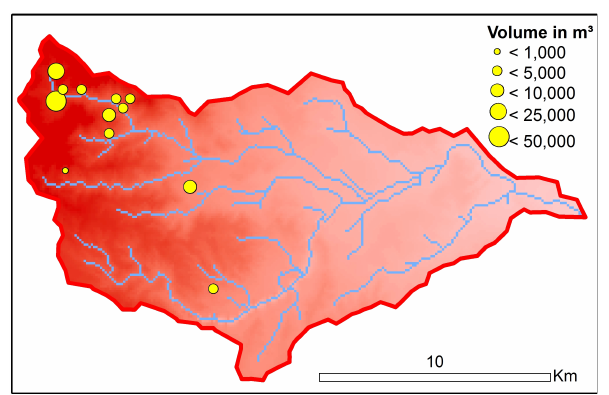
Fig. 5. Small-reservoir scenario for the Poyo catchment